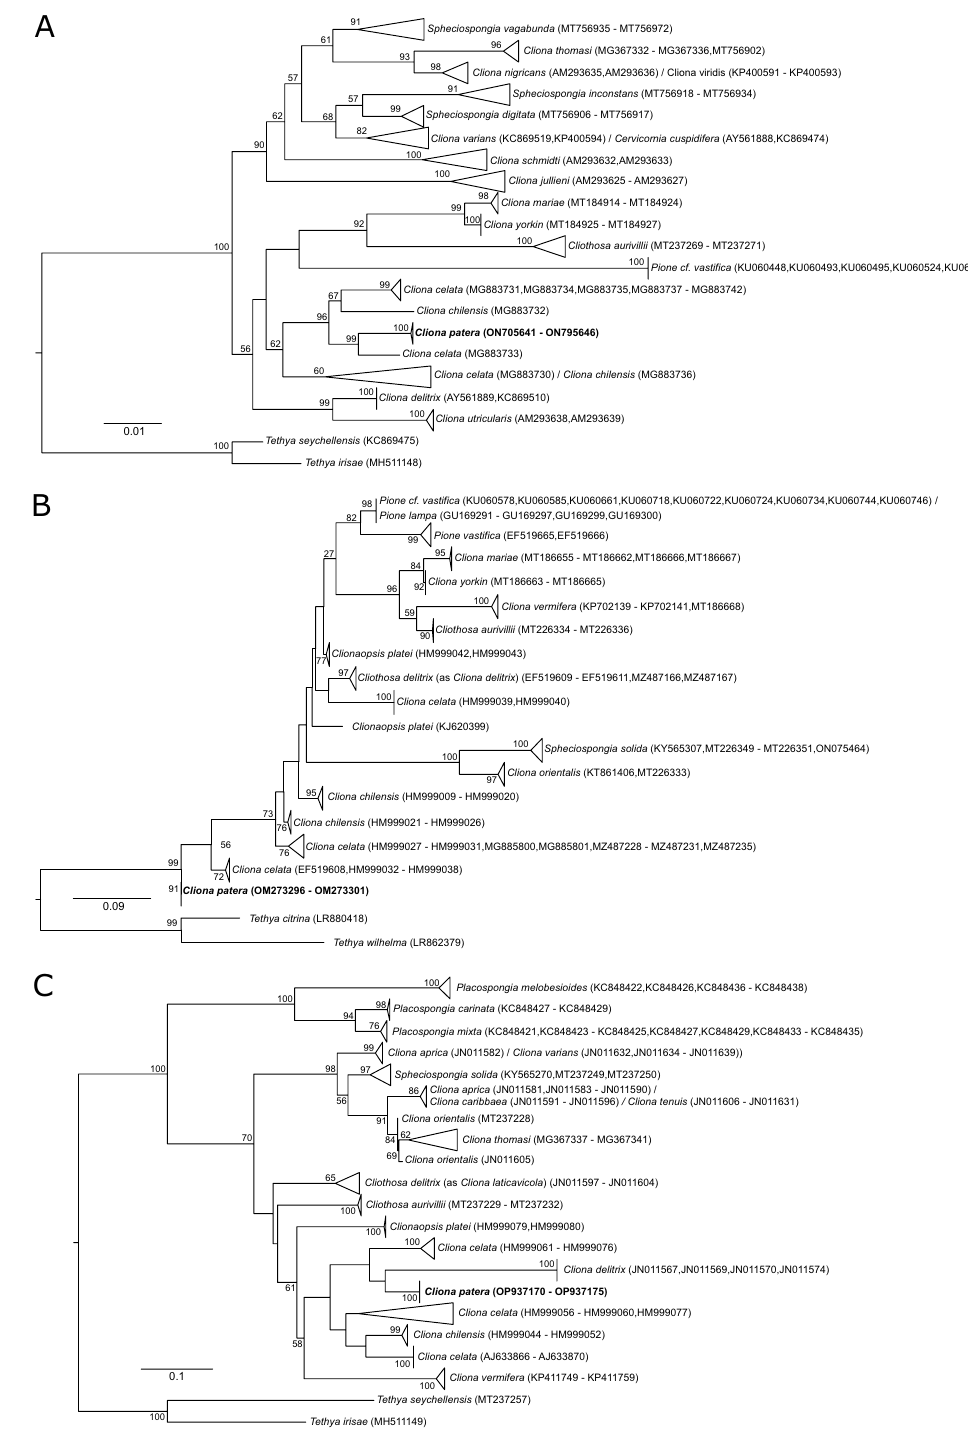
Figure 2. Maximum likelihood phylogeny of Clionaidae, with Tethya spp. as outgroup, based on three genes: ( A ) nuclear 28S rRNA; ( B ) mitochondrial cytochrome c oxidase subunit I (COI); ( C ) nuclear internal transcribed spacers (ITS). Numbers on nodes represent bootstrap support (≥ 50 only). Samples in bold represent those sequenced in this